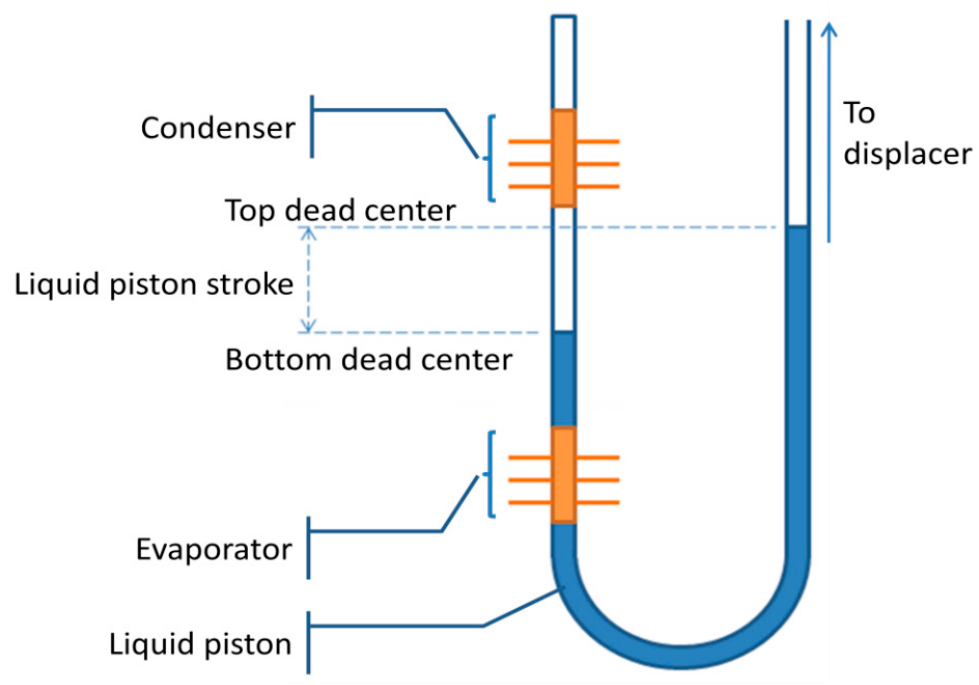
Figure 4. Schematic illustration of the liquid piston and conditioning unit.